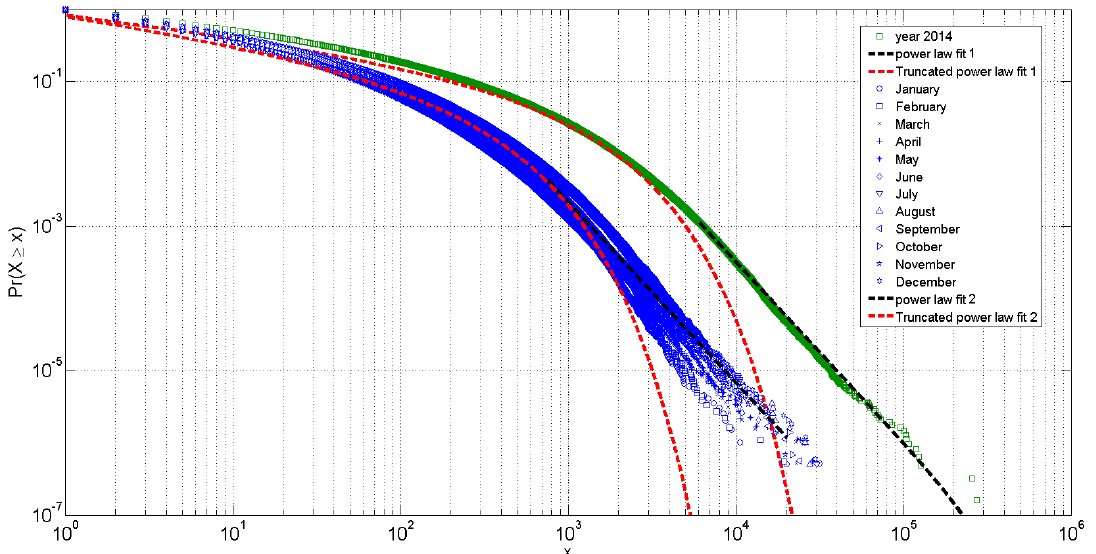
Figure 3. Two-tier power law distribution of the collective Twitter user visitation